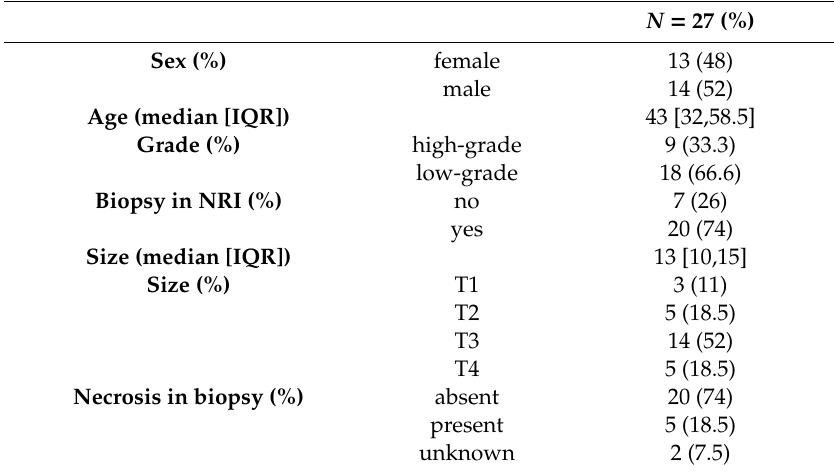
Table 1. Patient